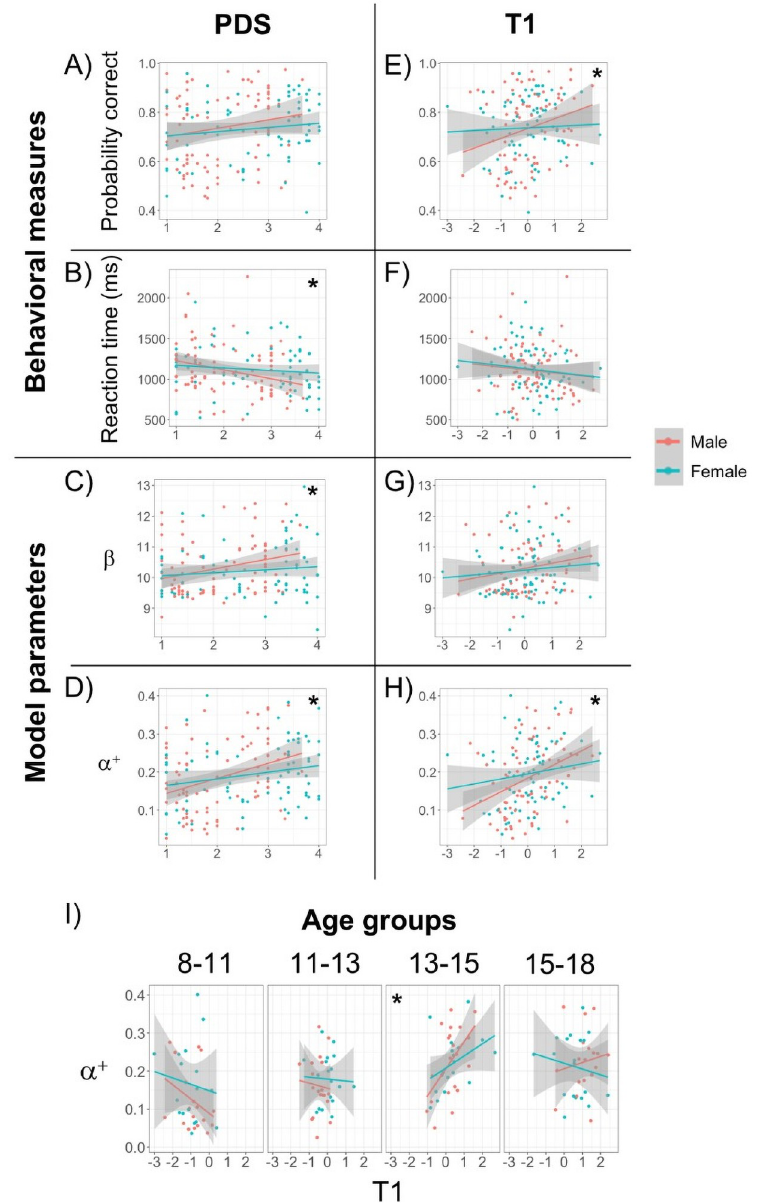
Fig 5. Pubertal effects on behavioral measures and model parameters. Scatter plots of (A) Puberty development scale (PDS) vs. overall performance, (B) PDS vs. median reaction time, (C) PDS vs. α + , and (D) PDS vs. β . (E-H) Same as (A-D) but with z-scored testosterone level (T1). (I) Scatter plot of T1 vs. α + in each of the four age groups younger than age 18. Each colored dot represents one participant under 18. Color indicates self-reported sex. There were no significant effects of sex or interactions. The lines represent best fitting linear regression lines. Shaded region represents 95% confidence interval. � indicates a significant main effect of PDS or T1 (see main text).